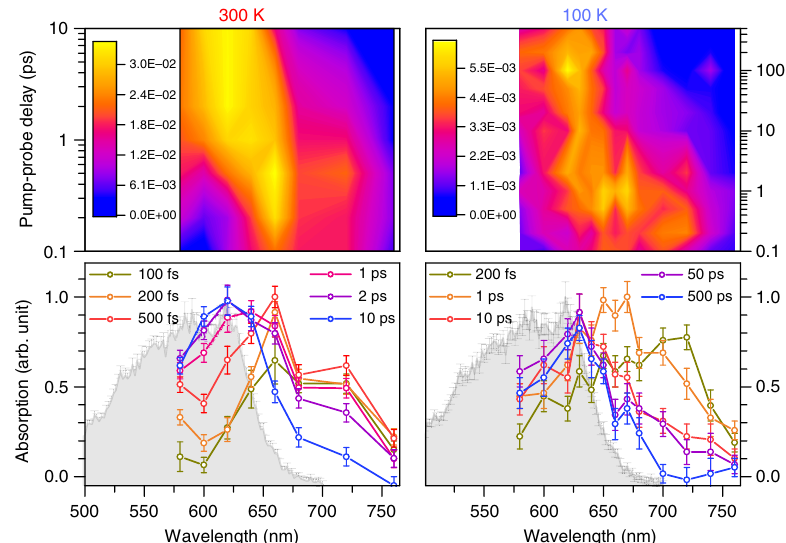
Fig. 5 Transient absorption (TA) measurements of retinal protonated Schiff-base (RPSB) in the gas phase at 300 and 100 K. The TA data are shown as a function of variable probe wavelength ( fi xed 600 nm pump). The grey area shows the ground-state absorption pro fi le at 300 K (one-photon spectrum). The transient absorption spectra at asymptotic long times (10 – 500 ps) correspond to absorption from a hot ground state, peaking at 620 nm. The excited- state absorption in the red part disappears with time concomitantly with a rise of the ground-state absorption with a lifetime, which strongly depends on temperature. Three major peaks at 720, 660, and 620 nm are seen at both temperatures. See discussion in the